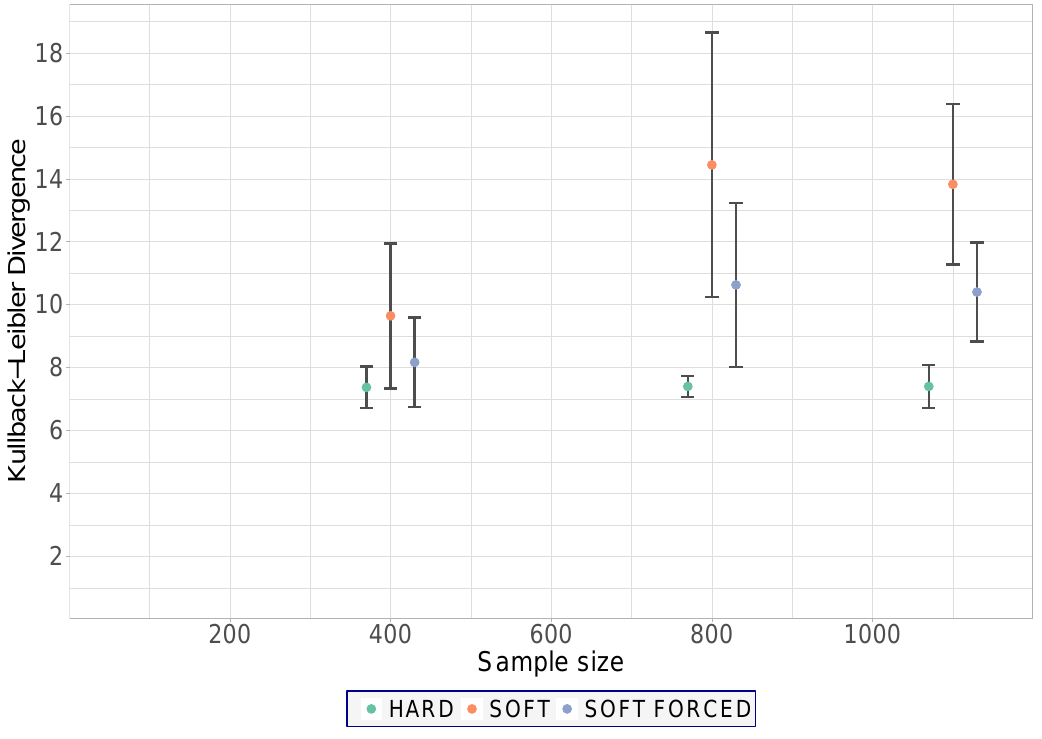
Figure 3. Leaf B. Hard EM achieves a value of KLD which is significantly smaller than that achieved by other EM algorithms (data sets with 5% missing data generated from the Property